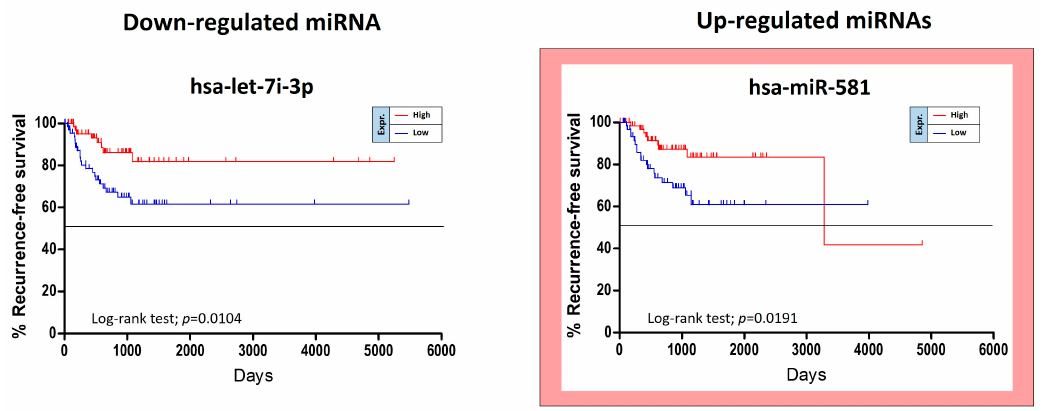
Figure 6. Recurrence-free survival analysis performed on the TCGA HNSC data.